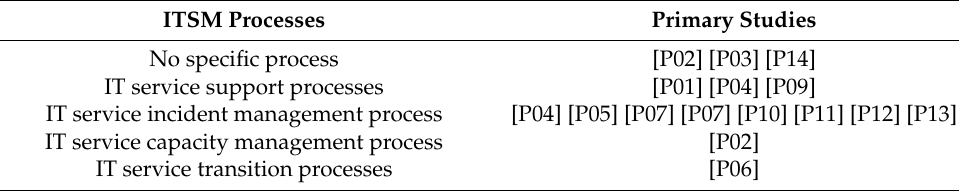
Figure 4. Number of primary studies by ITSM processes. Table 11. Classification of the primary studies regarding the gamified ITSM processes.